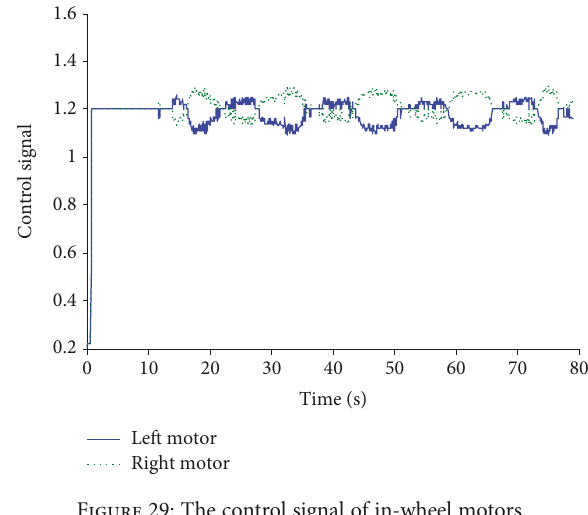
Figure 29: The control signal of in-wheel motors.